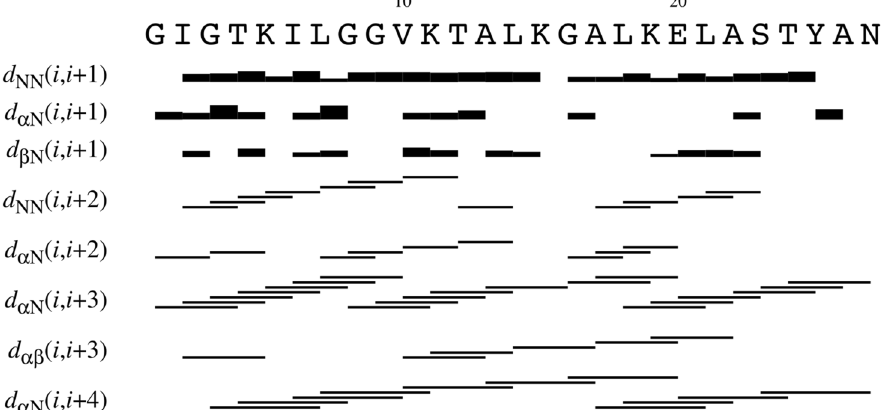
Figure 2. Short- and medium-range connectivities for palustrin-Ca in 50% TFE- d 3 -H 2 O.